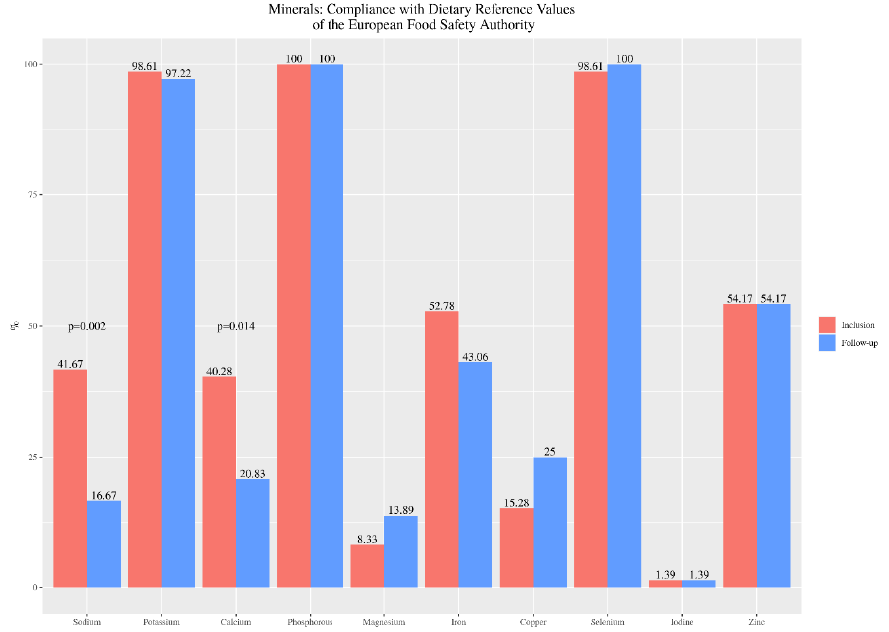
Figure 2. Percentage of celiac children’s compliance with the recommendations for minerals intake, from baseline (inclusion) to twelve months after nutrition education (follow-up).